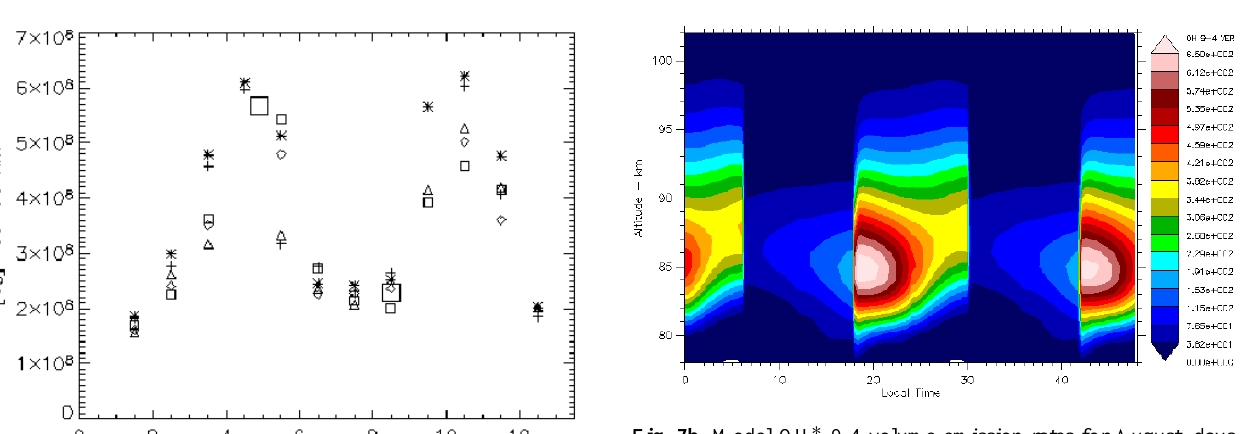
Fig. 7b. Model OH ∗ 9-4 volume emission rates for August, days seven through eight, from model [O 3 ] and (H) values. Note the scale is 1.77 times smaller than in Fig. 7a. VER units are in pho- tons cm − 3 s − 1